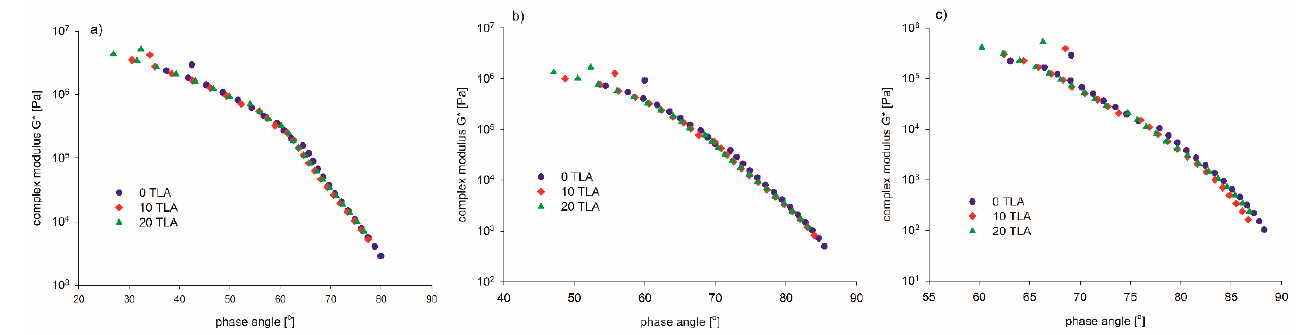
Figure 7. Complex modulus (G*) and phase angle ( δ ) of TLA-modified binders.